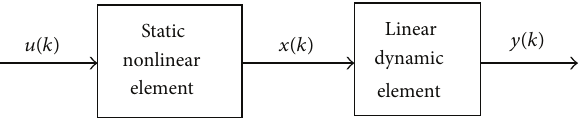
Figure 1: Hammerstein model structure.